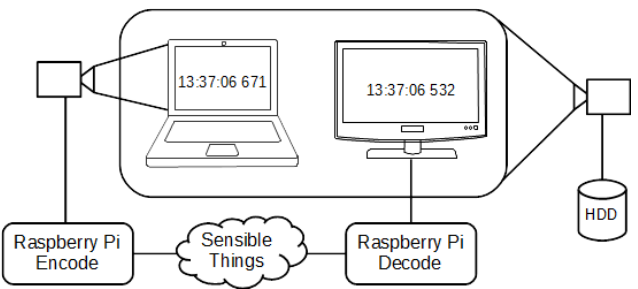
Figure 6. Measurement setup with SensibleThings with public Internet Protocol (IP).